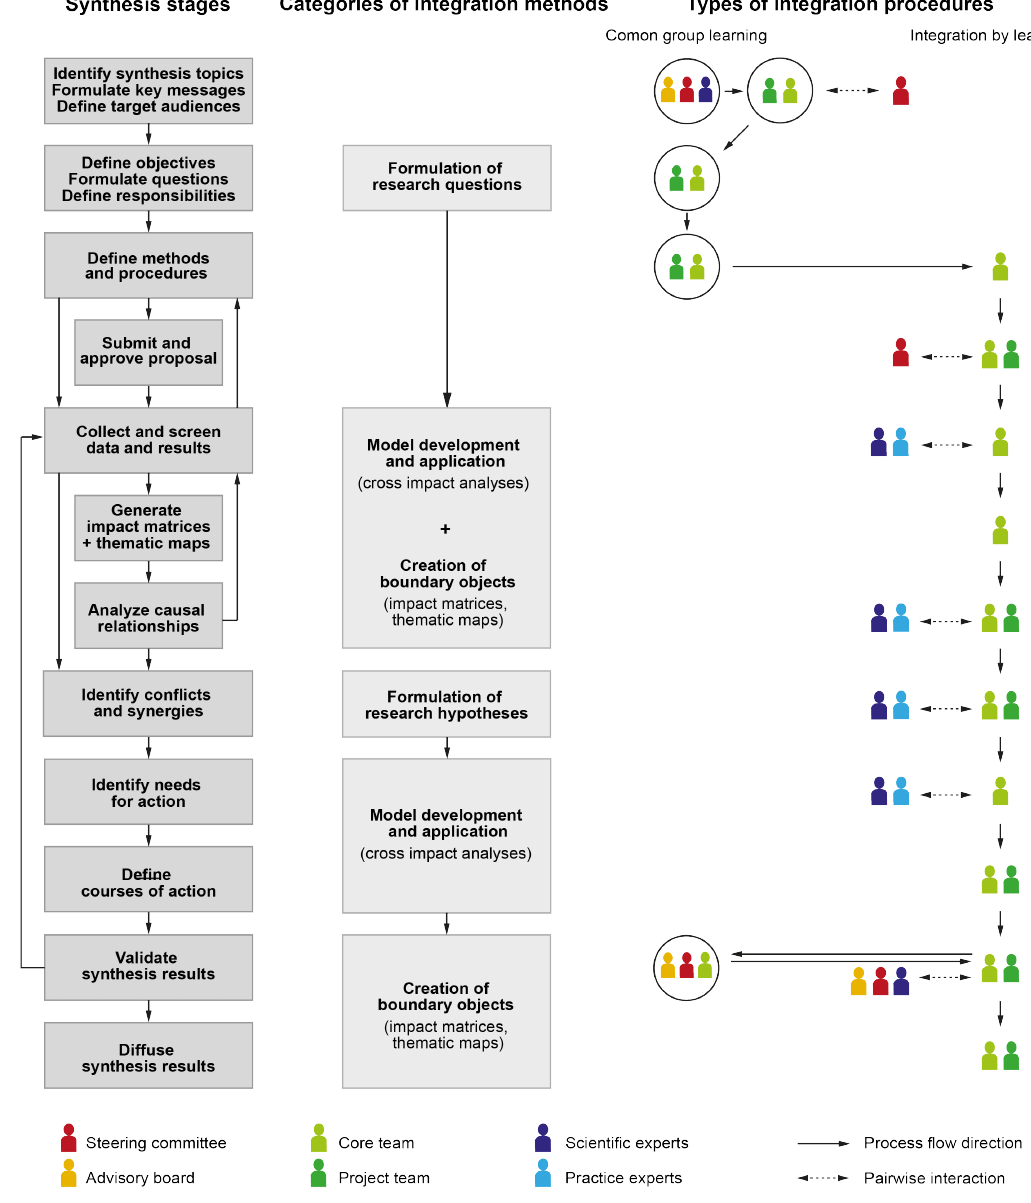
Fig. A3.2: Overall integration strategy of thematic synthesis 2 differentiated by synthesis stages, categories of integration methods, and types of integration procedures. The composition of the steering committee and the advisory board are described in the main text. Contrary to TS-1, TS-3, and TS-4, TS-2 involved a